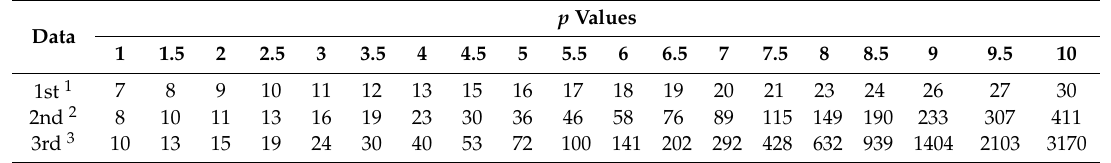
Figure 17. The effect of parameter p on the decrease of energy ratio in the ADHBS method for the three datasets. ( a ) The effect on the San Diego airport data. ( b ) The effect on the Indian Pines data. ( c ) The effect on the Okavango Delta data. In order to make the graph clearer, only part of the p values ’ detection results is displayed. Table 3. The number of iteration layers under different p values for the three datasets.